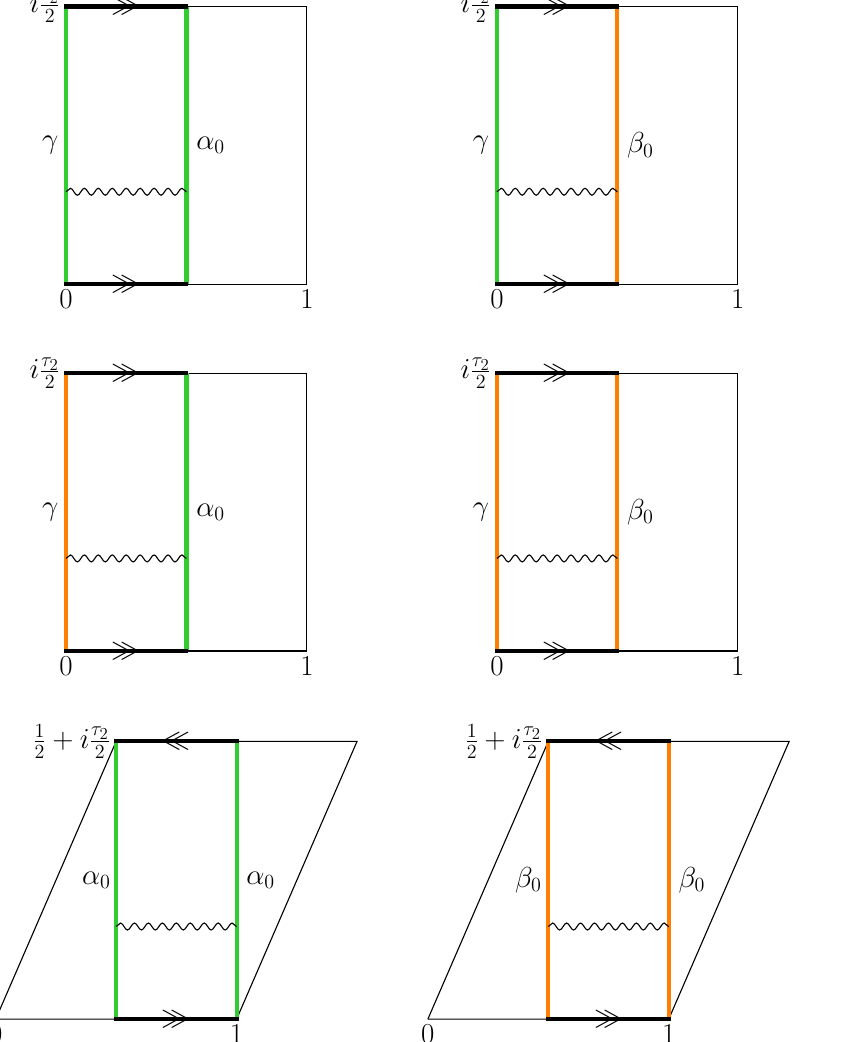
Figure 4. Open-string diagrams of figure 3 in the limit z 12